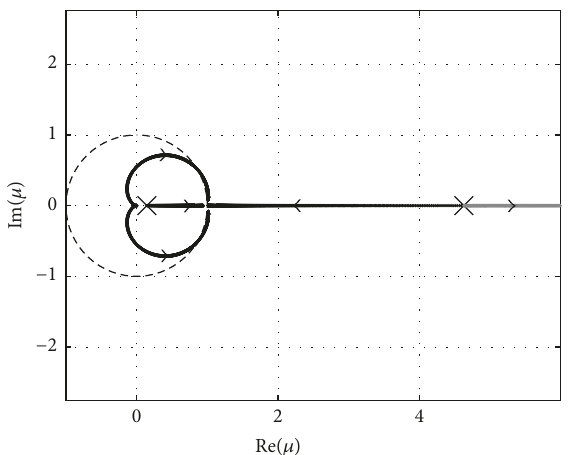
Figure 14: Root locus chart for the Floquet multipliers of the TUPO2 using the DFC. In black, the four largest magnitude Floquet multipliers for positive control gain 𝑘 . In dark gray, the largest magnitude Floquet multiplier for negative control gain 𝑘 . The Floquet multipliers of the free system orbit are represented by ( × ) and the unit circle by dashed line in black.